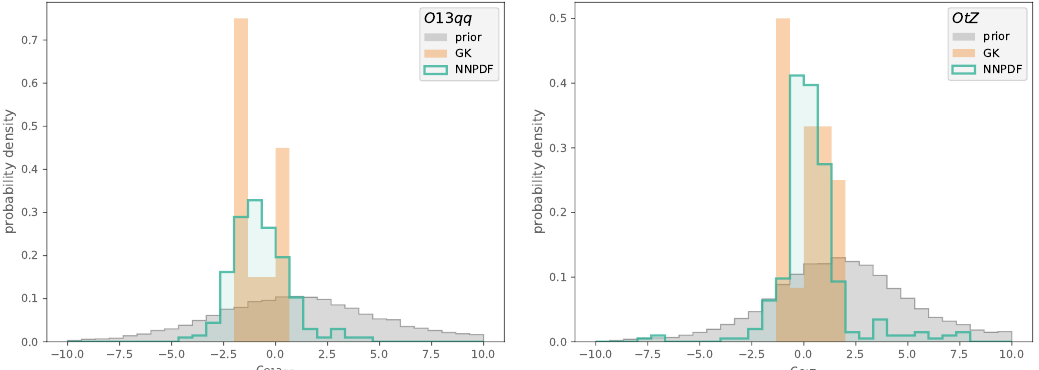
Figure 4.3: Same as Fig. 3.4 for the distributions of the O13qq and OtZ operators obtained from the prior and the reweighted sets with either the NNPDF or the GK weights. The number of effective replicas in the two cases is N